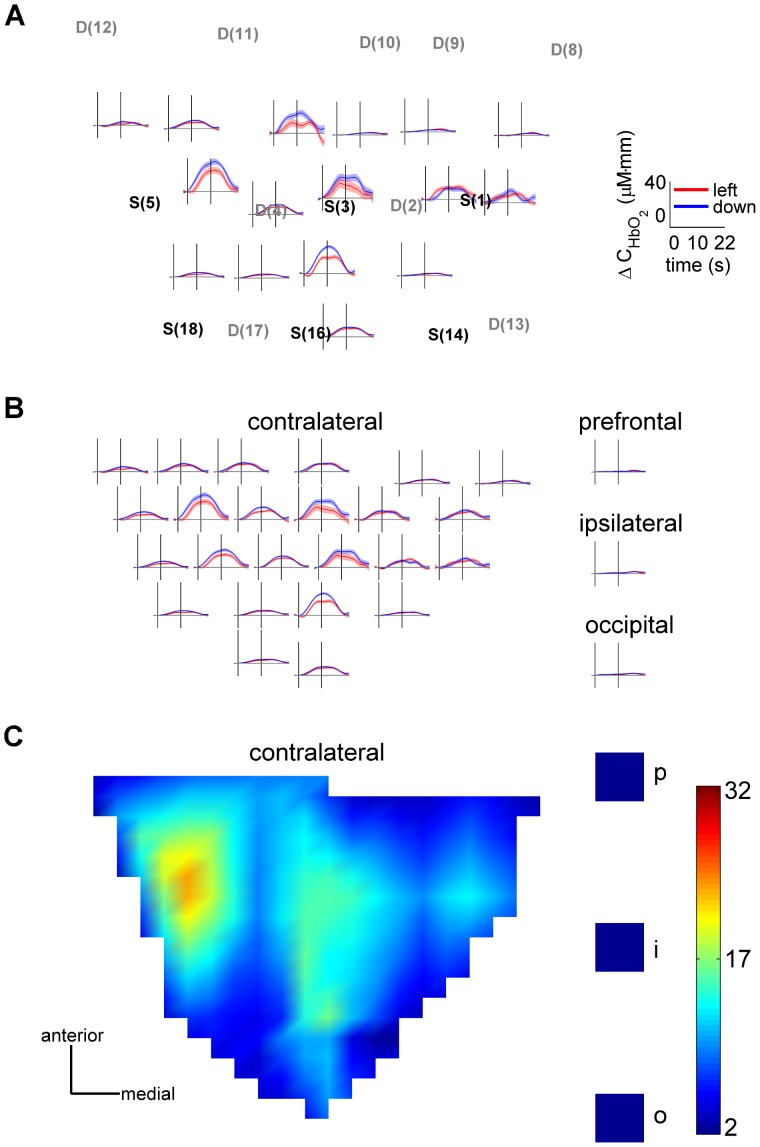
Topographic distribution of hemodynamic responses for subject 8.(A) Contralateral sensorimotor optodes mapped on a plane (3D positions shown in Figure 2) and average hemodynamic responses (HbO, acausal filter, Figure 3) for exemplary contralateral sensorimotor channels (insets). Insets are positioned in relation to the sources (S) and detectors (D). (B) Same as (A) but hemodynamic responses interpolated using original signals and channel positions. Insets in the right column show the hemodynamic responses averaged across trials and channels above the ipsilateral-prefrontal, ipsilateral-sensorimotor and ipsilateral-occipital brain areas as indicated (ipsilateral channels with source-detector distances <5.2 cm). (C) Hemodynamic responses for leftward movements as in (B) but color-coded amplitudes (in µM*mm) around movement end. This presentation is used in Figure 5.